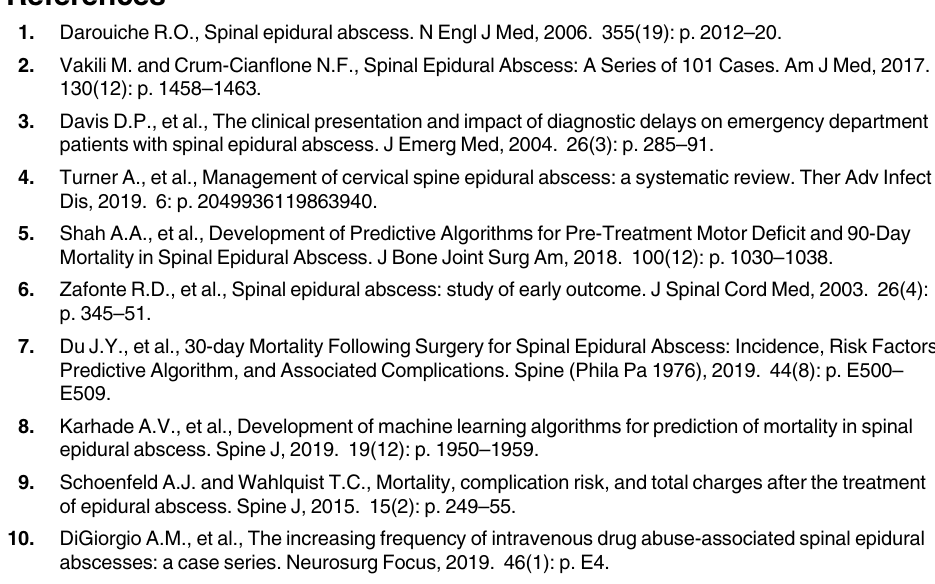
S1 Table. ICD-codes used to identify comorbid conditions. S2 Table. Model fits for tested latent class analyses by number of